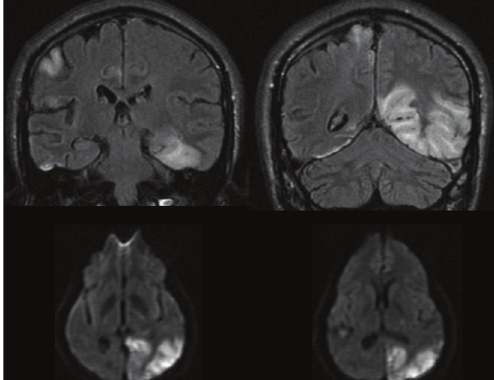
Figure 2: Visit 3 (10/2010) Coronal Flair MRI Image showing hypodensities in the left parietal and occipital lobes and near resolution of cerebral lesions noted on visit